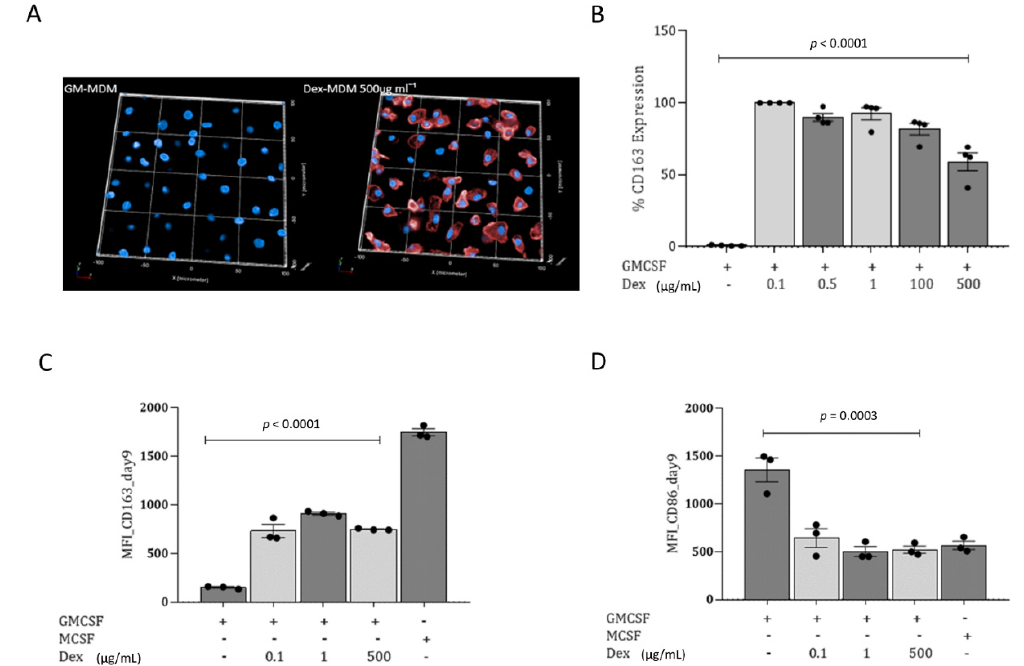
Figure 3. Dexamethasone upregulates the expression of the CD163 scavenger receptor. ( A ) α –human CD163 mAb-APC (red) and Höchst (blue) were applied for visualization purposes. HCS was performed and 3D image analyses done on GM- and Dex-MDMs. ( B ) Graph depicting upregulated expression of CD163 following 7-day treatment of GM-MDMs. Bars represent mean fluorescence intensity ± SD of n = 4 donors. The x-axis represents treatment conditions. GM-MDMs were treated with Dex for 24h post-differentiation period (7 days) and were repolarized into anti-inflammatory phenotypes depicted by upregulated expression of CD163 ( C ) and decreased expression of CD86 ( D ). Graphs demonstrate repolarization in three independent donors. Values are expressed as MFI ± SD, p -values indicated were calculated by one-way ANOVA.